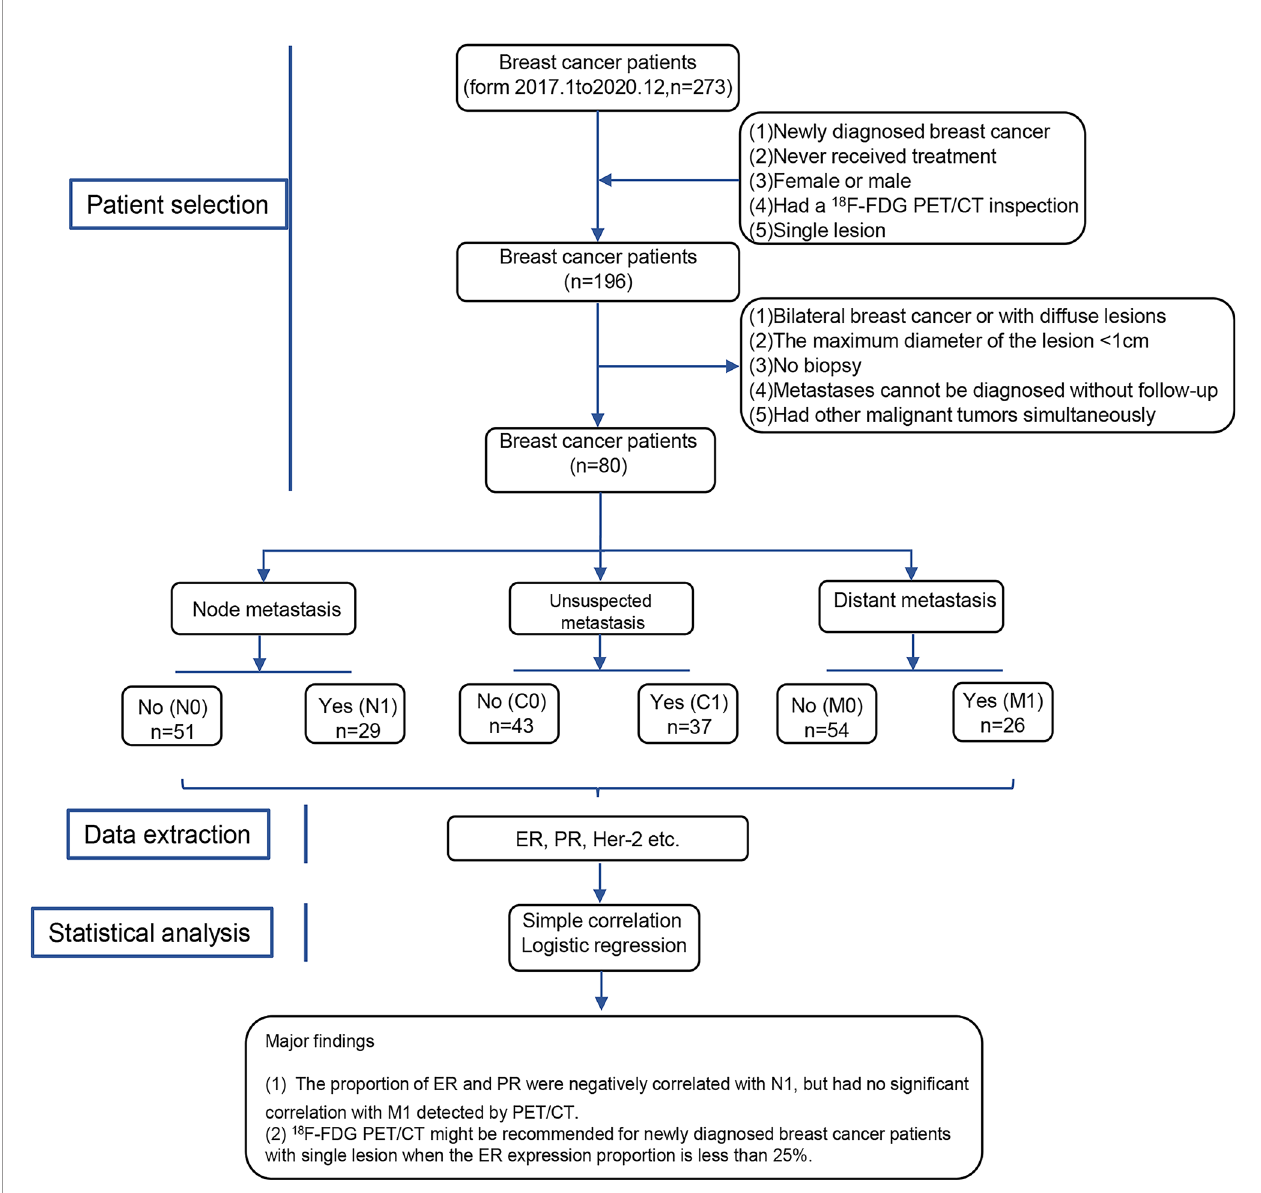
FIGURE 1 | Work fl ow for this study design. N0, no extraaxillary lymph node metastasis; N1, extraaxillary lymph node metastasis; M0, no distant metastasis; M1, distant metastasis; C0, no unsuspected metastasis; C1, unsuspected metastasis and with initial treatment plan changed; ER, estrogen receptor; PR, progesterone receptor; Her-2, human epidermal growth factor receptor